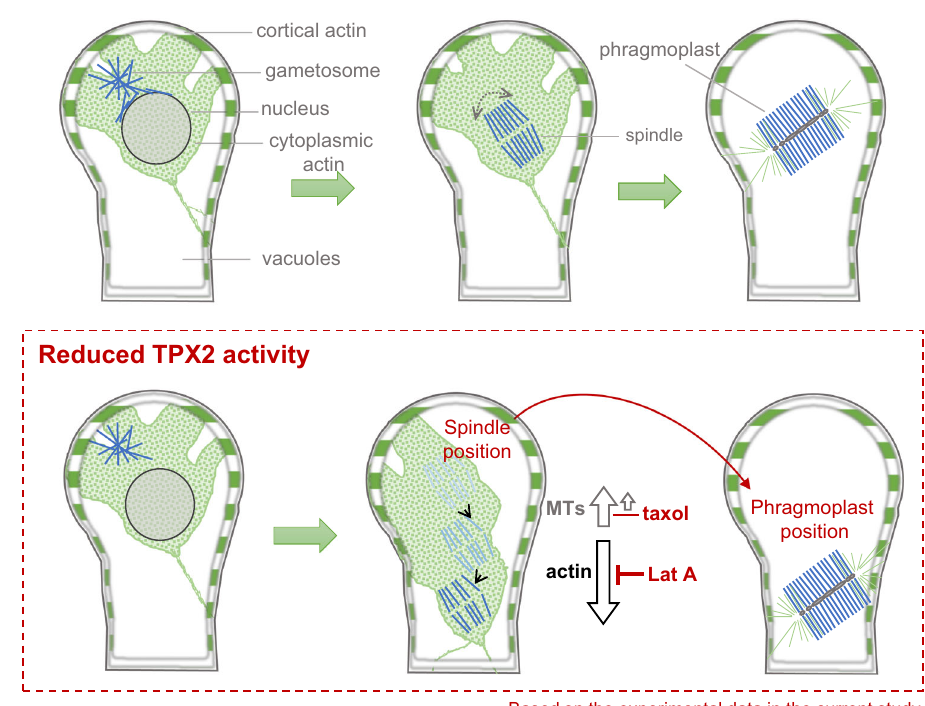
Fig. 8 Schematic representation of the spindle impact on phragmoplast position and orientation in the gametophore initial cells of P. patens . The upper panel shows the fi rst asymmetric division of gametophore initial in wild-type cells. Spindle, consisting of microtubules, drives chromosome segregation and cell plate expansion. Cytoplasmic actin surrounds the nucleus before nuclear envelope breakdown and the spindle in early mitosis. During cytokinesis, cytoplasmic actin localizes to the phragmoplast. The bottom panel summarizes the fi ndings of the present study and the role of the microtubule-associated protein TPX2 in spindle positioning. In the scenario where TPX2 function is reduced, the spindle can be transported to the bottom of the gametophore initial cell, compromising the cell plate position and daughter cell ratios in asymmetric cell division. The cytoplasm changes its position together with the moving spindle, and spindle motility is completely inhibited by depolymerizing actin fi laments with latrunculin A (Lat A). Stabilizing microtubules with taxol could partially counteract spindle transport, suggesting that under normal conditions, microtubules are able to fi x the spindle position against actin